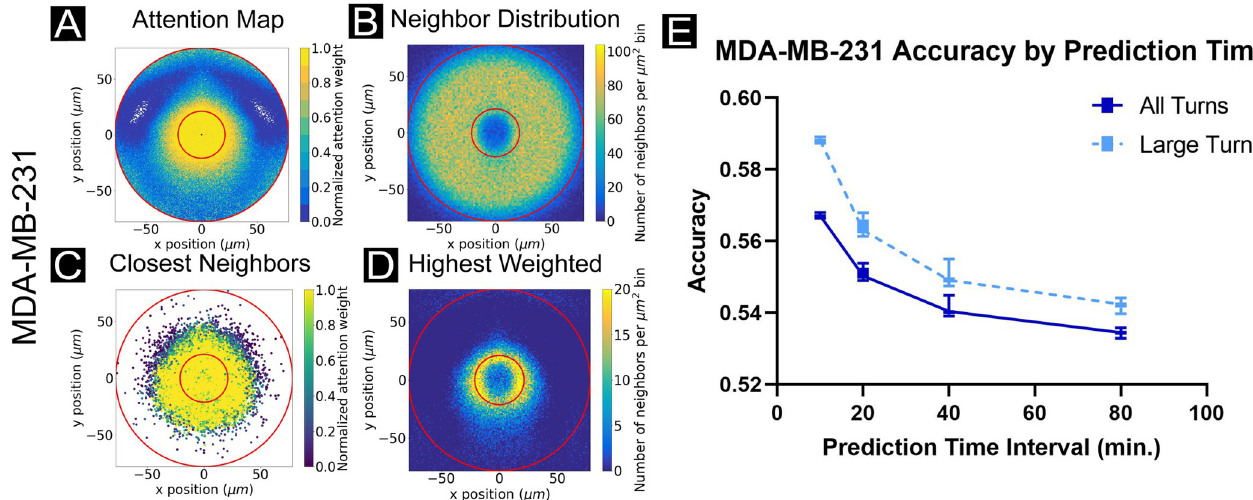
Fig 4. Breaking coordination: attention in metastatic cancer cell line MDA-MB-231. (A) Normalized attention weight contour plot, (B) neighbor location histogram, (C) closest neighbor scatter plot, as colored by normalized attention weights, and (D) histogram of highest weighted neighbors, with all plots analogous to those in Figs 2 and 3. Results shown for MDA-MD-231 cells with cell trajectory points taken every 5 minutes, and networks encompassing 10 neighbors with 20 minute prediction times. This cancer line functions as a control, as the cancer cells are highly uncoordinated, resulting in nearly equal attention weight applied to local neighbors in all directions. (E) Network accuracy plots as prediction time interval is varied, aggregated over networks accounting for 5–50 neighbors in increments of 5. Solid lines reflect accuracy scores for all turning angles in the focal agent trajectory; dashed lines reflect only large turns ( ± 20–160˚). Accuracy decreases with increasing prediction interval and varies little as a function of neighbors observed by the network. Cell trajectory timesteps were fixed at 5 minutes.